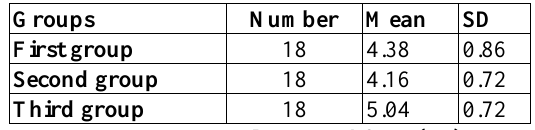
Table 4: ANOVA test to detect the difference in ∆ E between the 3 groups included in this study for the middle third.